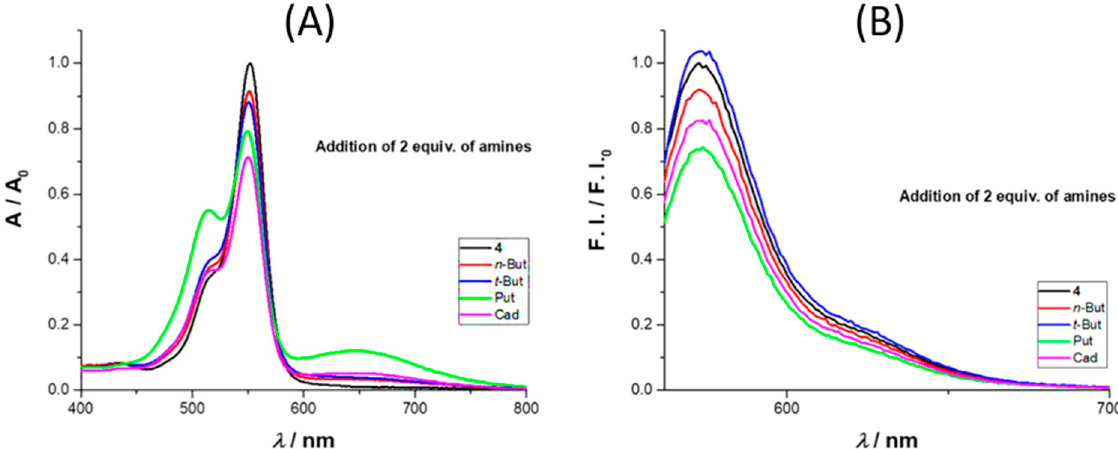
Figure 2. Comparison of the absorbance ( A ) and emission intensity ( B ) spectra of 4 toward 2 equiv. of n -butylamine ( n -But, red line), t -butylamine ( t -But, blue line), putrescine (Put, green line), and cadaverine (Cad, magenta line) in solution (acetonitrile, 25 °C).